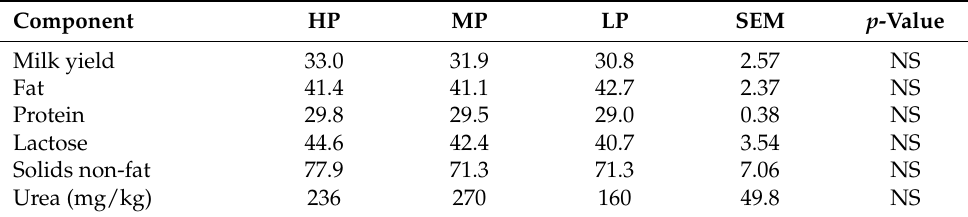
Table 3. Production (kg/day) and composition (g/kg) of milk from dairy cows feeding diets with high protein (HP), medium protein (MP), and low protein (LP) levels. Component